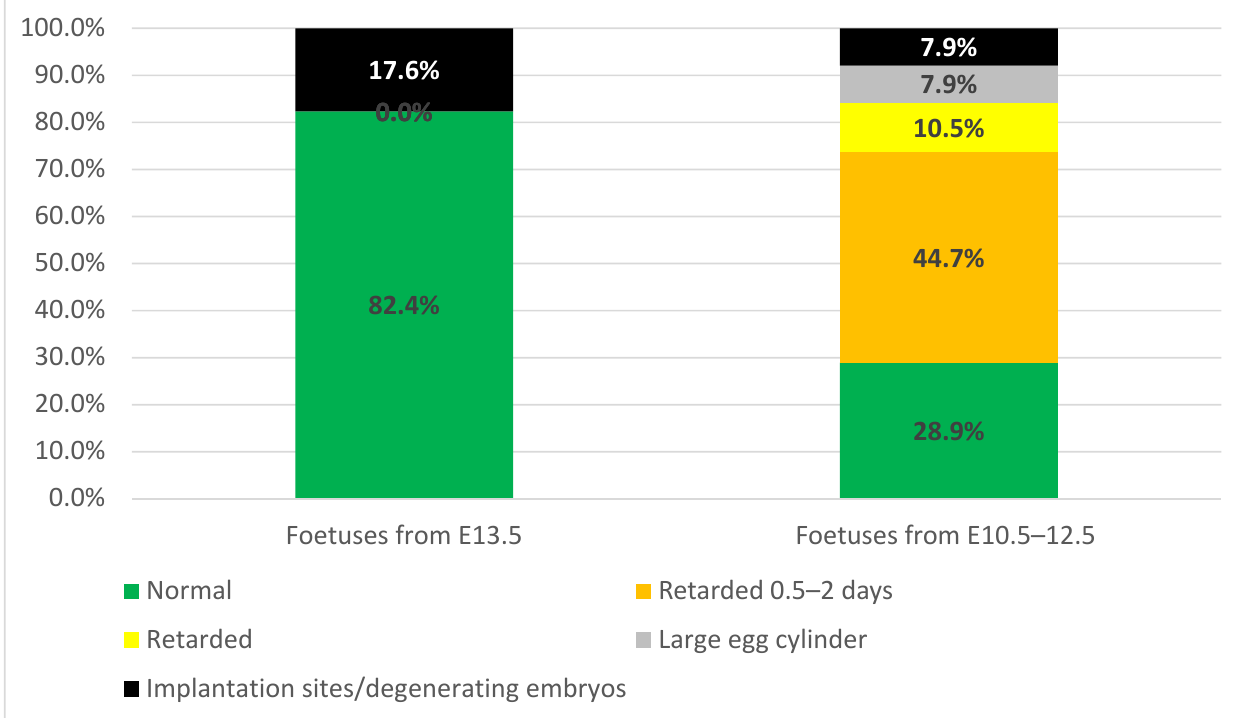
Figure 4. Development of chimaeric foetuses. Chart showing percentage of foetuses with normal and delayed or abnormal development. The number 0.0% in the category “Foetuses from E13.5” reflects the lack of retarded foetuses in this group.